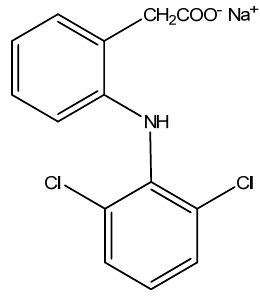
Figure 1. The chemical structure of sodium